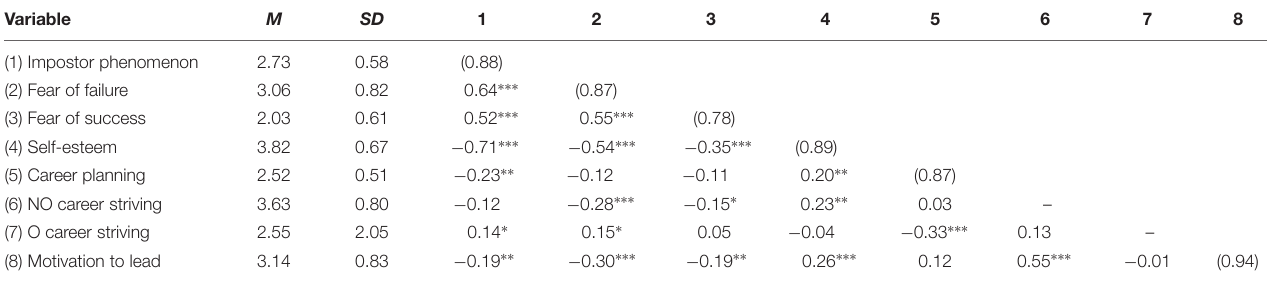
TABLE 1 | Means, standard deviations, and correlations for the main variables in Study 1.